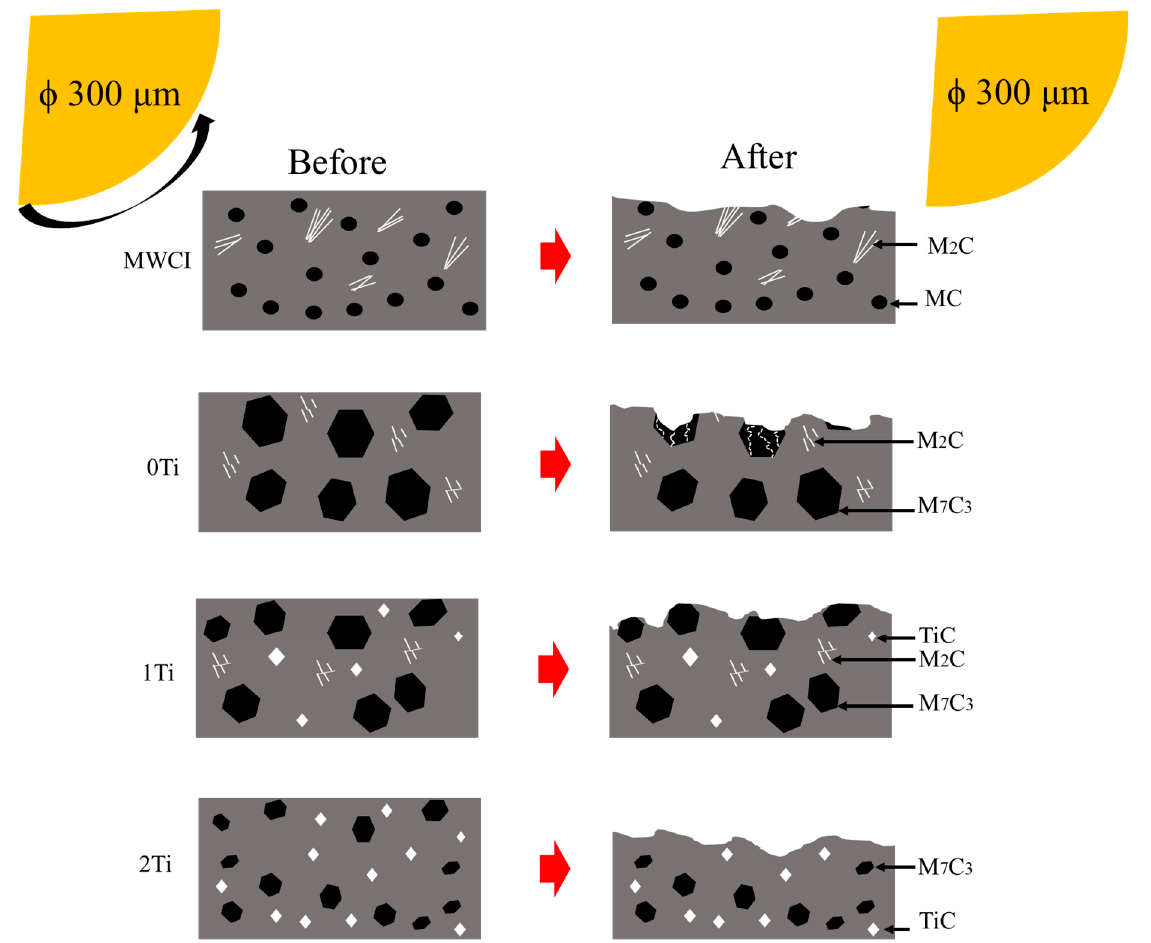
Figure 14. The schematic of abrasive wear on all specimens for large silica sand.